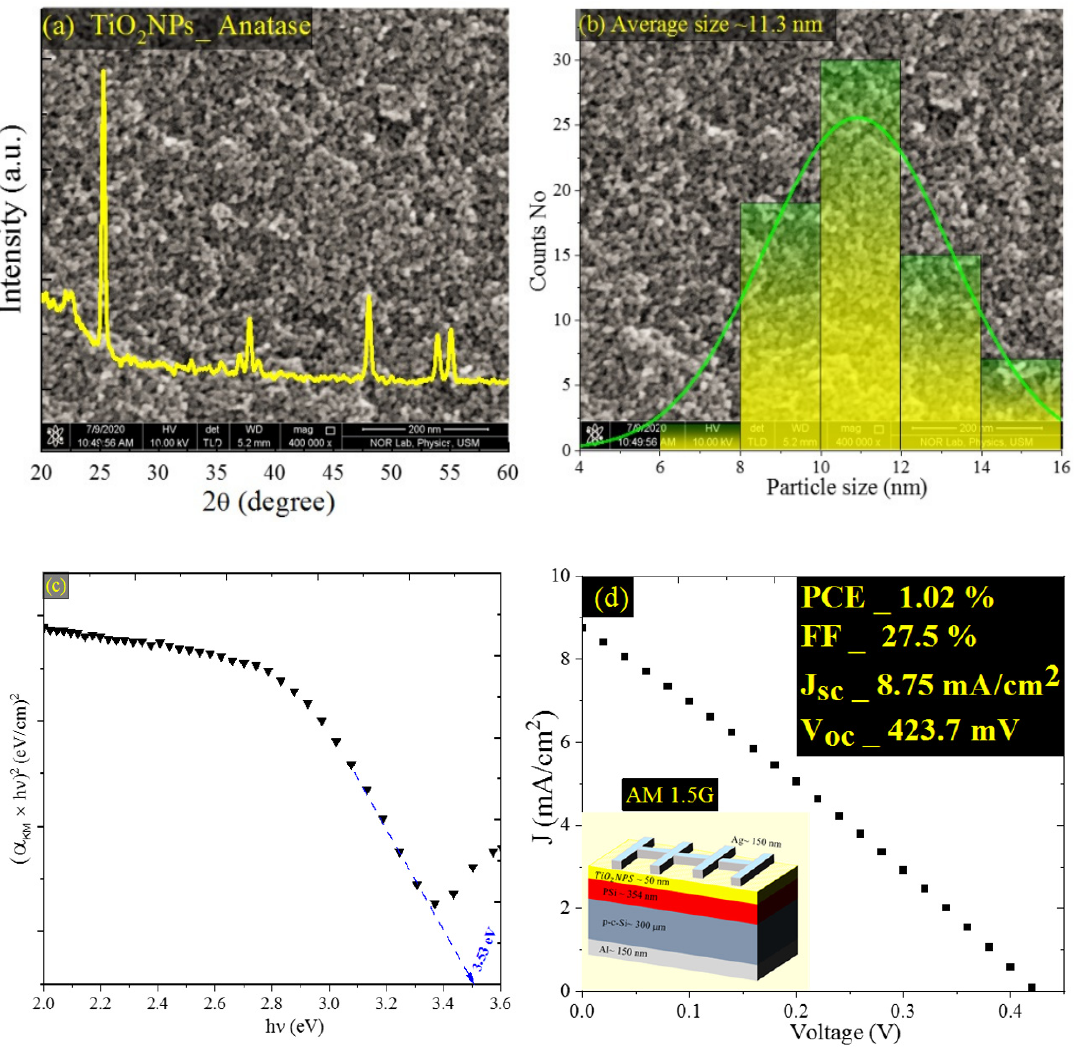
Figure 5. ( a ) FESEM image with XRD pattern, ( b ) FESEM image with size distribution and ( c ) Kubelka–Munk plot of TiO 2 NPs annealed at 500 °C. ( d ) I-V characteristics of Al/p-c-Si/PSi/TiO 2 NPs/Ag photovoltaic cell (insets shows the cell layout, PCE, FF, J SC , and V OC ).